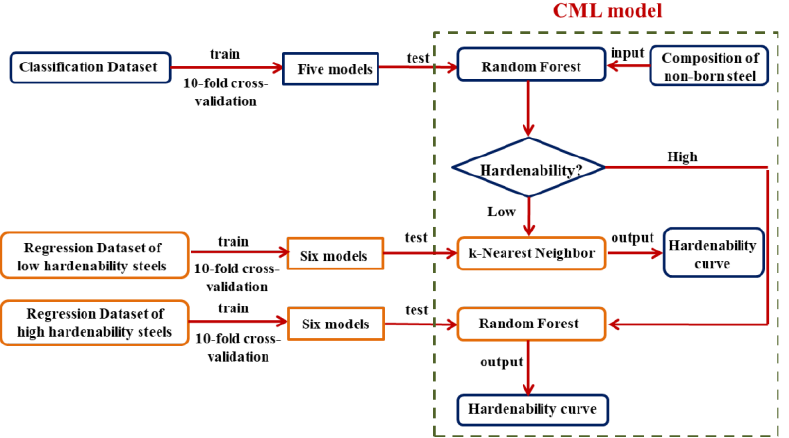
Figure 6. Correlation coefficients and error values of the prediction result on the test sets.